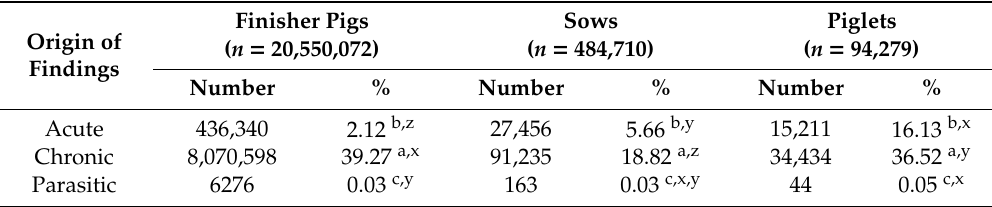
Table 2. Comparison of the number of individual patho-anatomic findings in lungs in finisher pigs, sows and piglets slaughtered in the slaughterhouses.